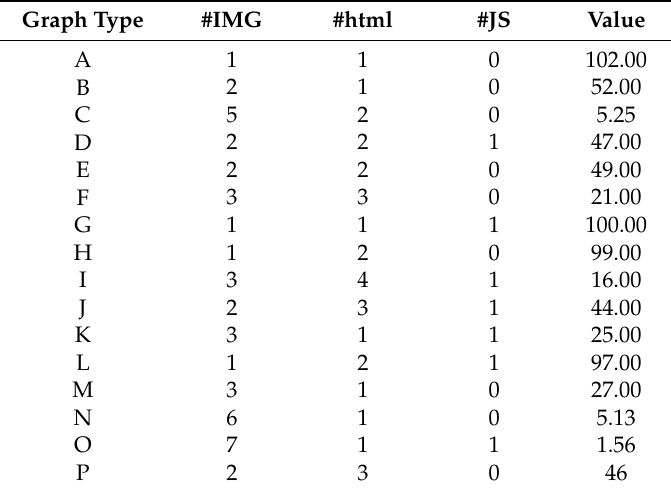
Table 3. Values of the different types of